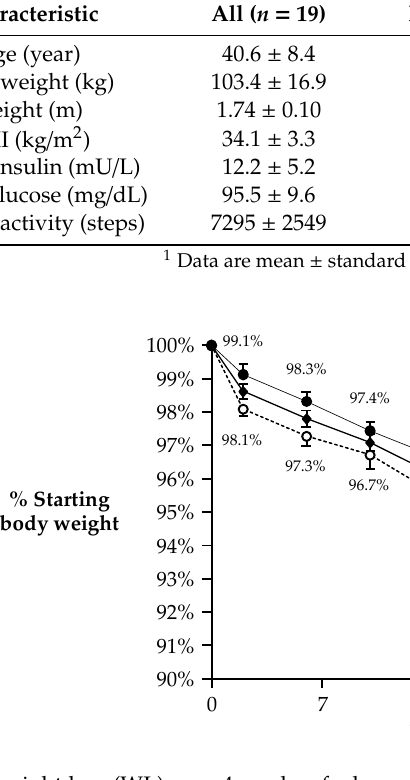
Figure 2. Body weight loss (WL) over 4 weeks of a low-carbohydrate (low-CHO), energy restricted diet. Data are mean ± SE and reported for N = 19 subjects who had complete data for food cravings. Analysis of body WL over time revealed significant effects for men and women combined (center line, with diamond symbols) and also separately for the sexes. WL in men (dotted line with open circles) was significantly greater than in women (top line with closed circles, p = 0.002, ANOVA effect of sex). This figure is modified from Syed-Majid et al. [30] with permission.